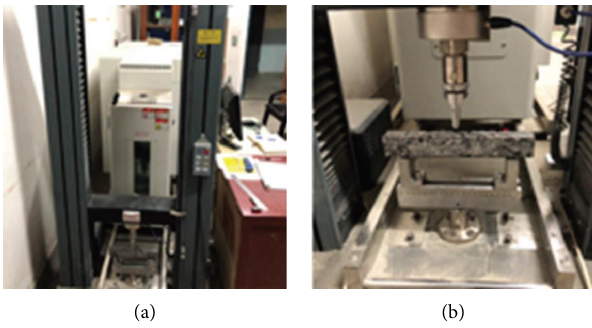
Figure 4: Flexural and tensile test of the specimen. (a) Universal testing machine. (b) Bending test